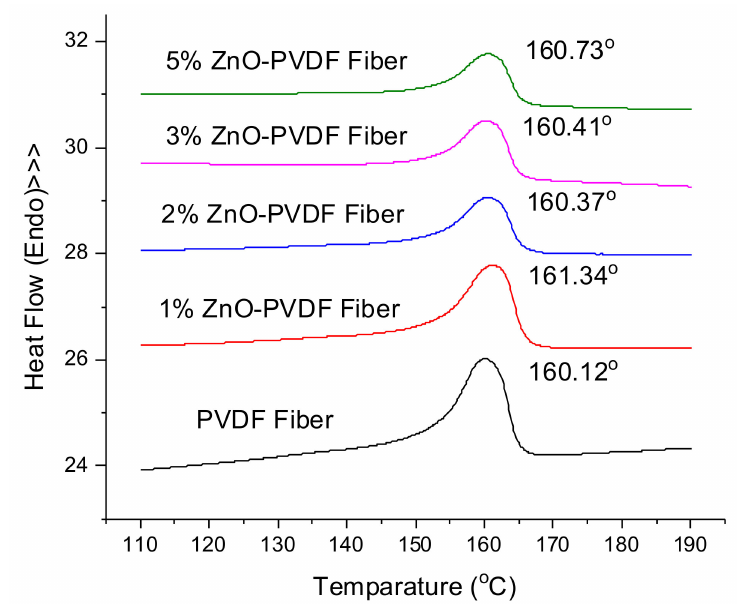
Figure 7. Di ff erential scanning calorimetry (DSC) curves for the PVDF and ZnO-PVDF fiber